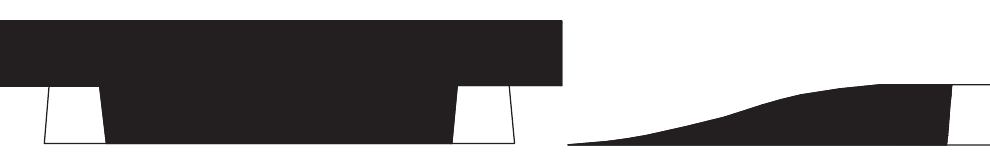
Figure 9: Recovery comparison [23].